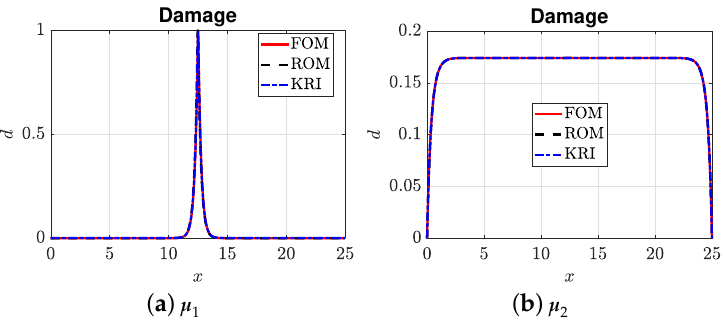
(corresponding to a completely broken bar) and µ 1